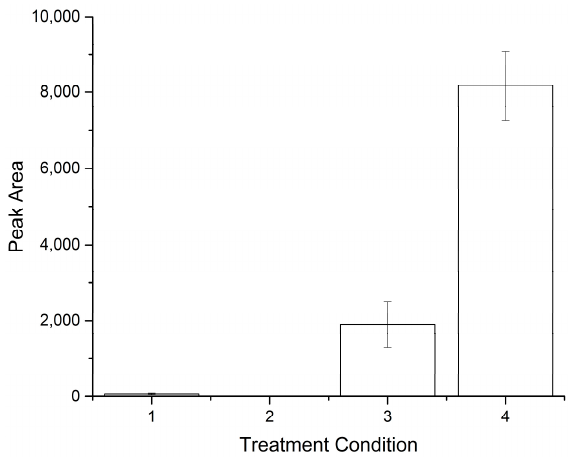
Figure 4. Results from direct analysis of semen samples on FTA ® paper using a variety of treatment conditions for disulphide bond reduction ( n = 3). A range of treatment options were tested: (1) semen added to FTA ® paper and dried; (2) semen added to FTA ® paper, dried, 40 µ L of 1 M DTT added and dried; (3) semen and 1 M DTT mixed 50:50 ( v / v ), added to FTA ® paper and dried; (4) 40 µ L of 1 M